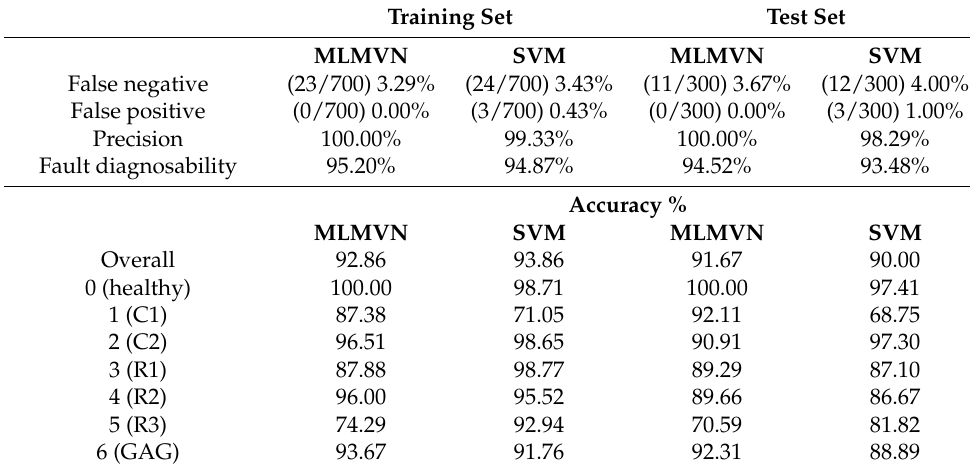
Table 1. Fault classification results in